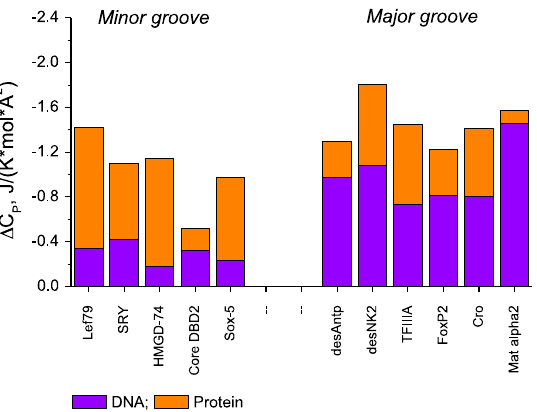
Figure 6. Surface-normalized (i.e., per A 2 ) observed heat capacity changes, ∆ Cp obs , for binding DBDs to their optimal recognition target sequences. The contribution from protein components (in orange), ∆ Cp prot , was calculated using Equation (1). The DNA contributions, ∆ Cp DNA (in blue), were obtained by subtraction from ∆ Cp obs [19,22].